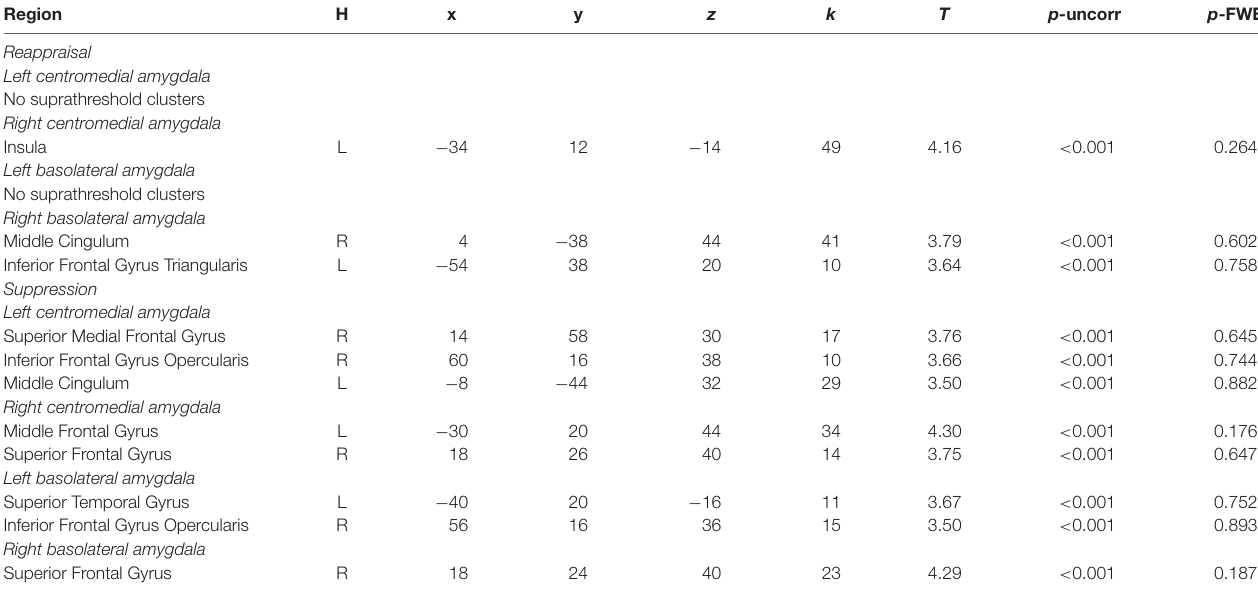
Superior Frontal Gyrus R